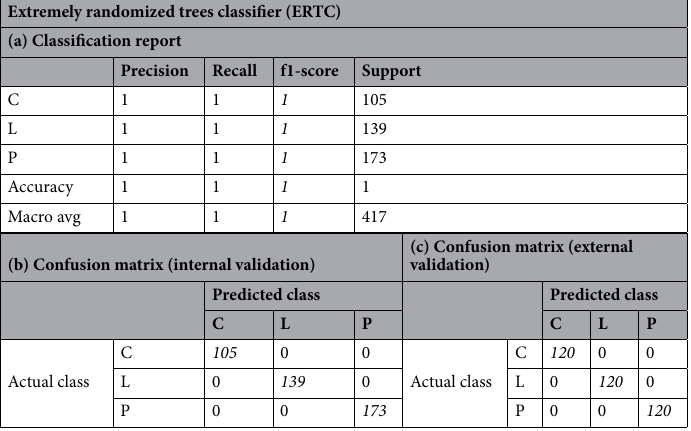
Fig. 2a. Including more spectral features for the algorithm training (or equivalently by reducing the threshold of variable importance), the accuracy of the algorithm was found increasing. As an example, after including 10 spectral features, the algorithm attained an accuracy as high as 98.3% (see e.g. Fig. 2a). Among the most important spectral features are the CN (Δν = + 1) band, the C I 795.2 nm and 843.1 nm atomic emissions, the two N I triplets centered around 744 and 820 nm, and multiple N I spectral lines at about 865 nm and the O I 926.4 nm line. The contribution of the continuum background was found to be rather weak for the discrimination procedure since, only with the aforementioned emissions the algorithm attained quite high accuracy. Similar behavior was observed for the H γ 434.1 nm, multiple C I spectral lines (i.e., 247.9 nm, 906.2 nm, and 940.6 nm), the CN (Δν = 0, + 1) band and the O I 615.7 nm and 715.7 nm lines, together with the O I triplet located around 777 nm. All these spectral features were found to have relatively weak contribution to the accuracy of the algorithm. It is useful to remind at this point, that the main olive oil constituents (corresponding to 98–98.5%) are the oleic acid (C 18 H 34 O 2 ), the linoleic acid (C 18 H 32 O 2 ), the palmitic acid (C 16 H 32 O 2 ) and glycerol (C 3 H 8 O 3 ), i.e. molecules consisting from C, O and H. Therefore, at first glance, it is reasonable to expect that emissions arising